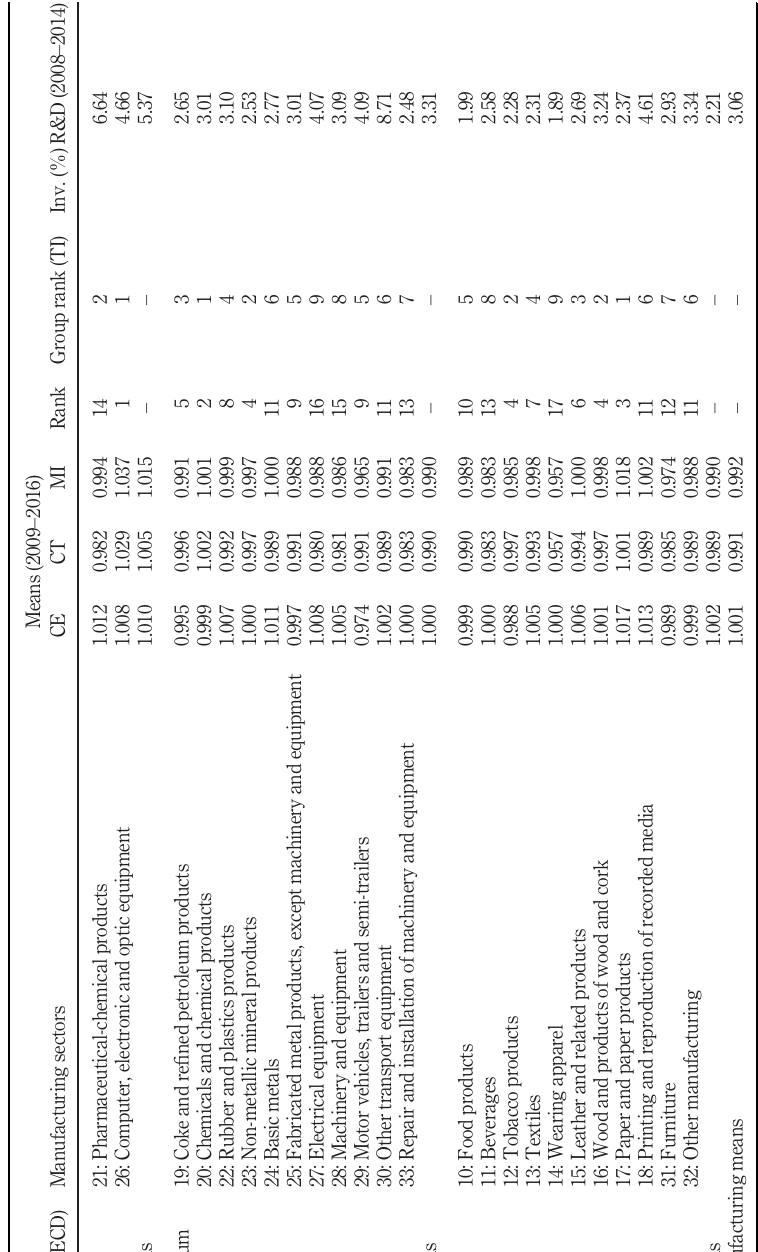
Table 2. Technology intensity (TI), changes in efficiency (CE), changes in technology (CT), Malmquist index (MI) and investments in R&D of the manufacturing